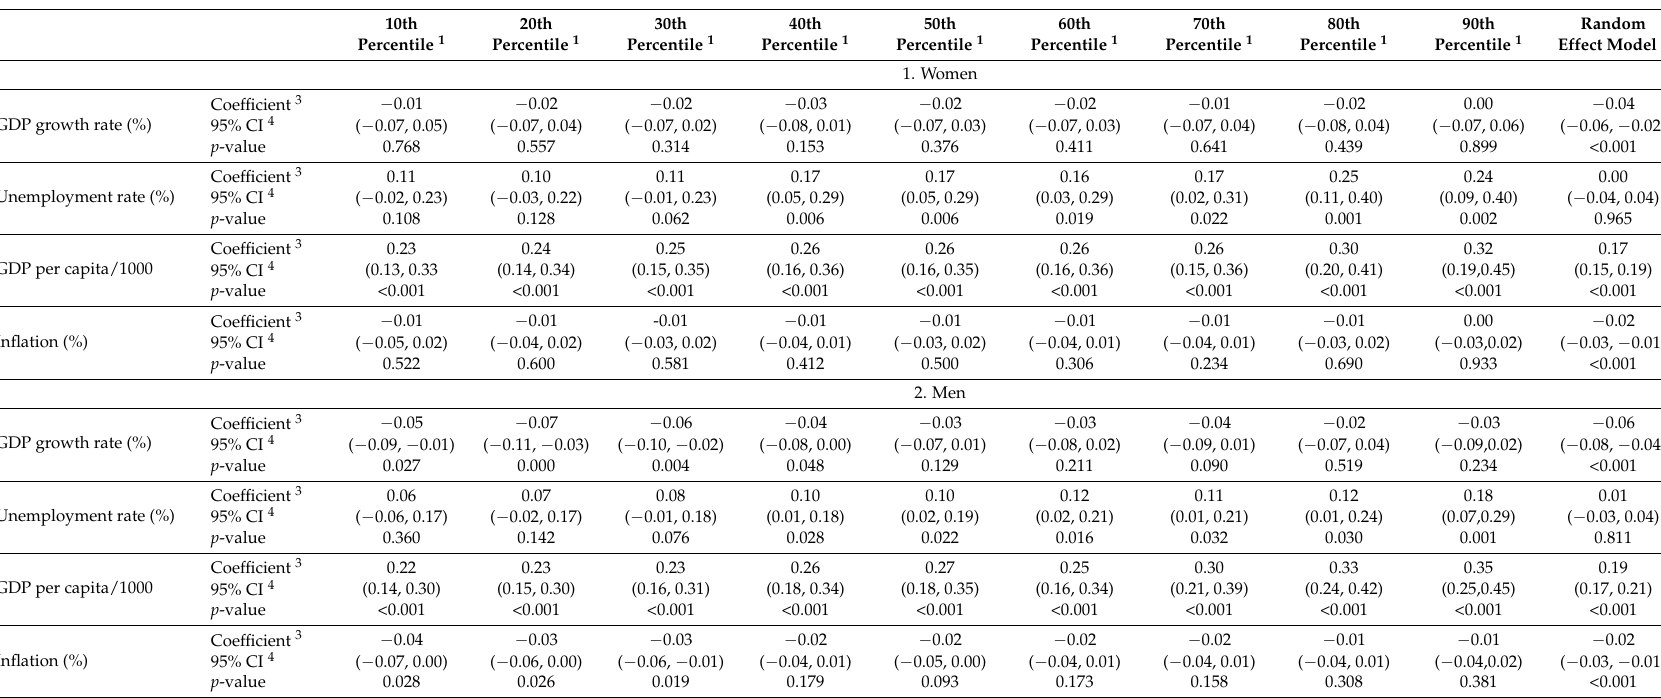
Table 3. Association between life expectancy and macroeconomic factors in 65 Belt and Road countries: linear quantile mixed